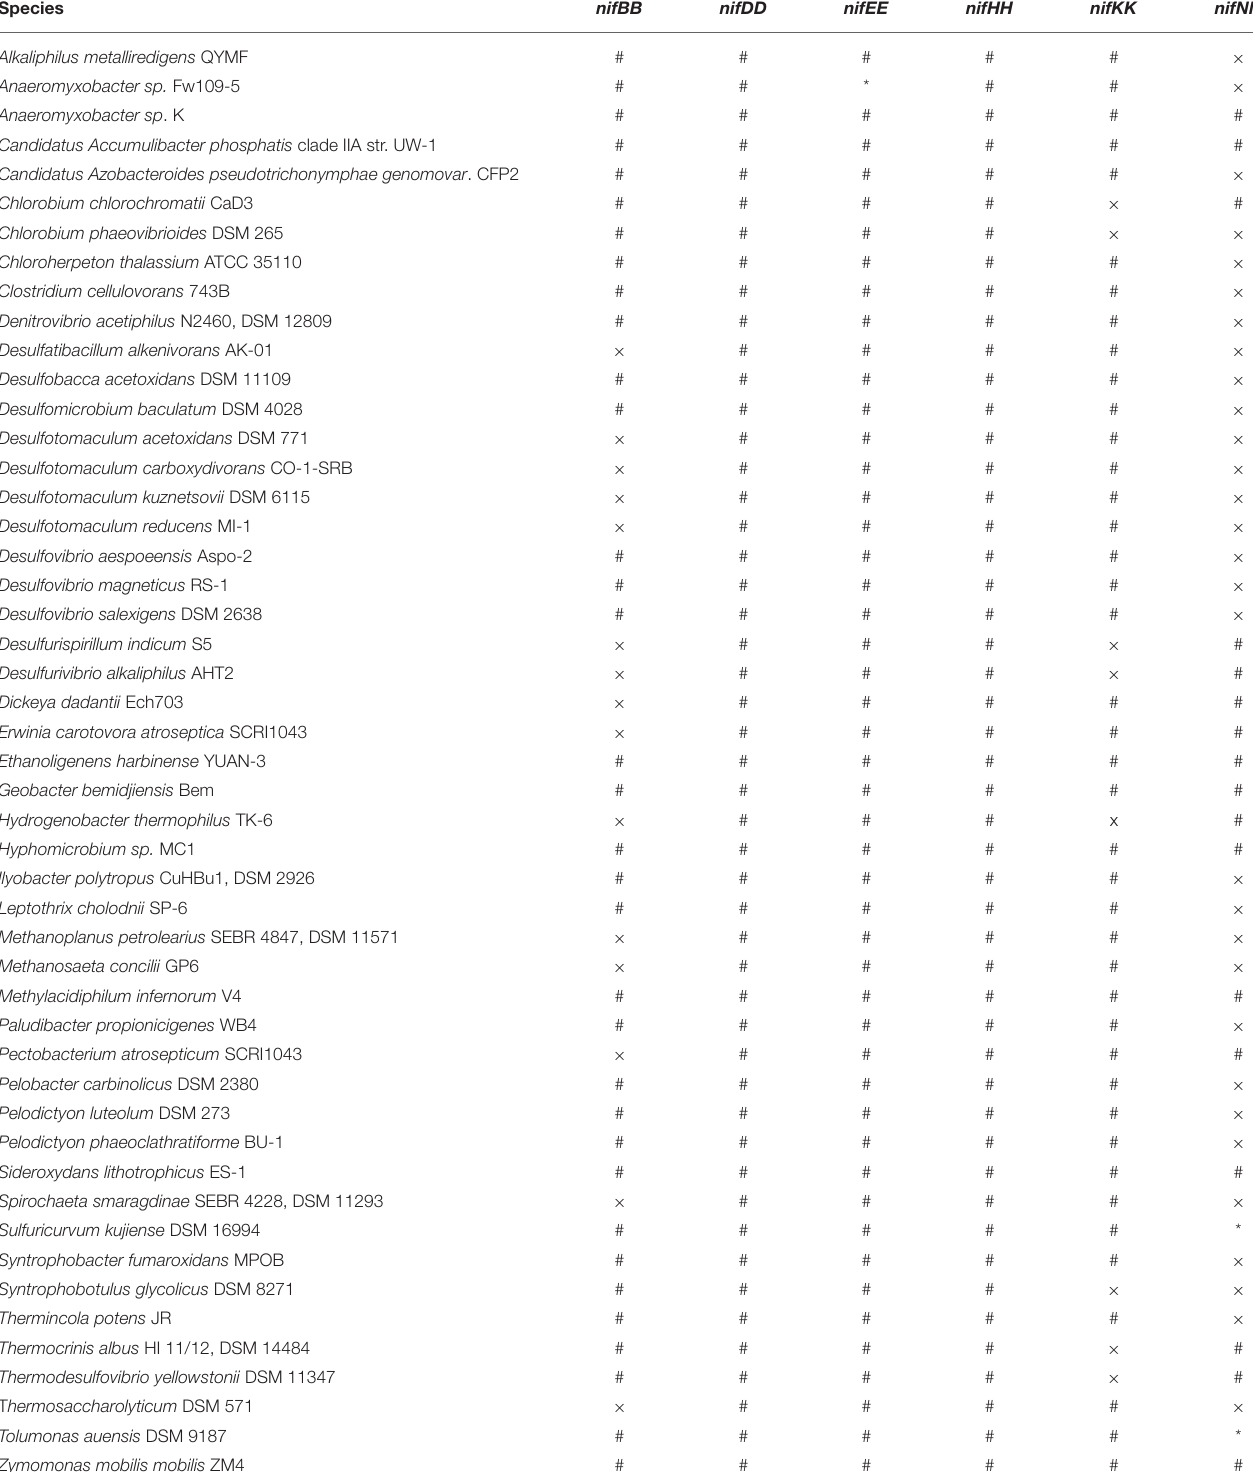
TABLE 5 | Performance of nifPred in identifying nif proteins in 49 diaztroph species. Species nifBB Alkaliphilus metalliredigens